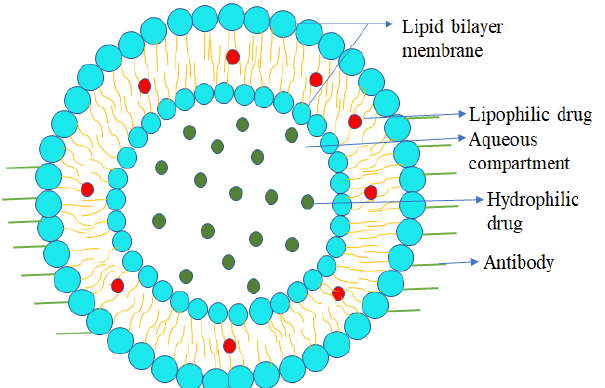
Fig. 7. Generalized structure of liposome